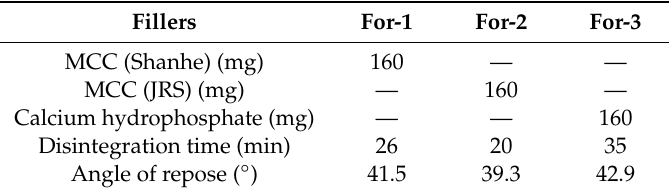
Table 5. The screening results of the fillers.